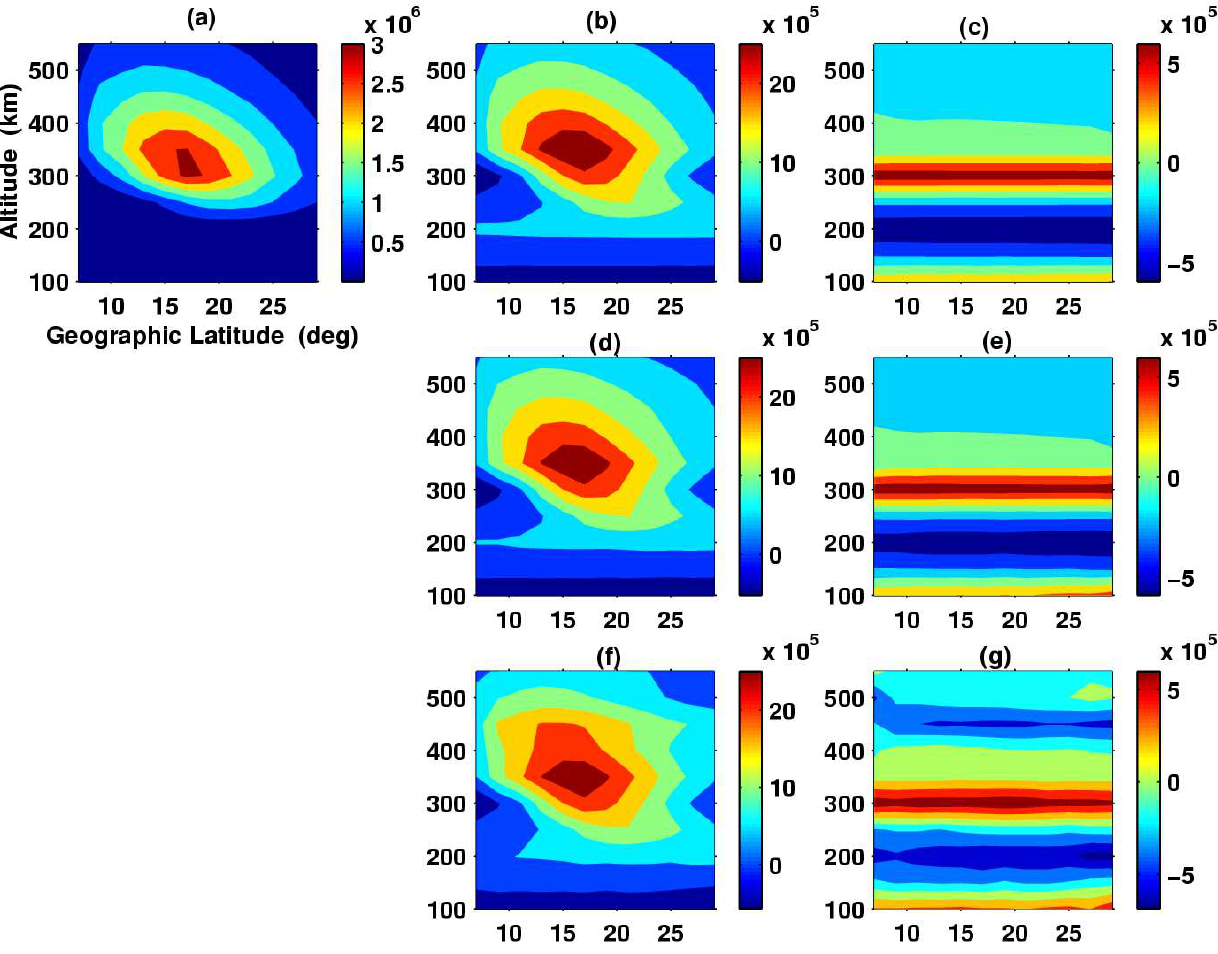
Fig. 12. ( a ) Model ionosphere with an electron density depletion of 30%. ( b ) The reconstructed image, with a bias error of 1% of the minimum TEC when the 3 smallest singular values are omitted from the solution. ( d ) Reconstruction with a bias error of 5% of the minimum TEC when the 4 smallest singular values are truncated. ( f ) The reconstruction with random errors ranging from 0.001% to1% of the average TEC added to input data and with the 4 lowest singular values truncated. ( c , e , g ) The corresponding differences from the model in Fig.